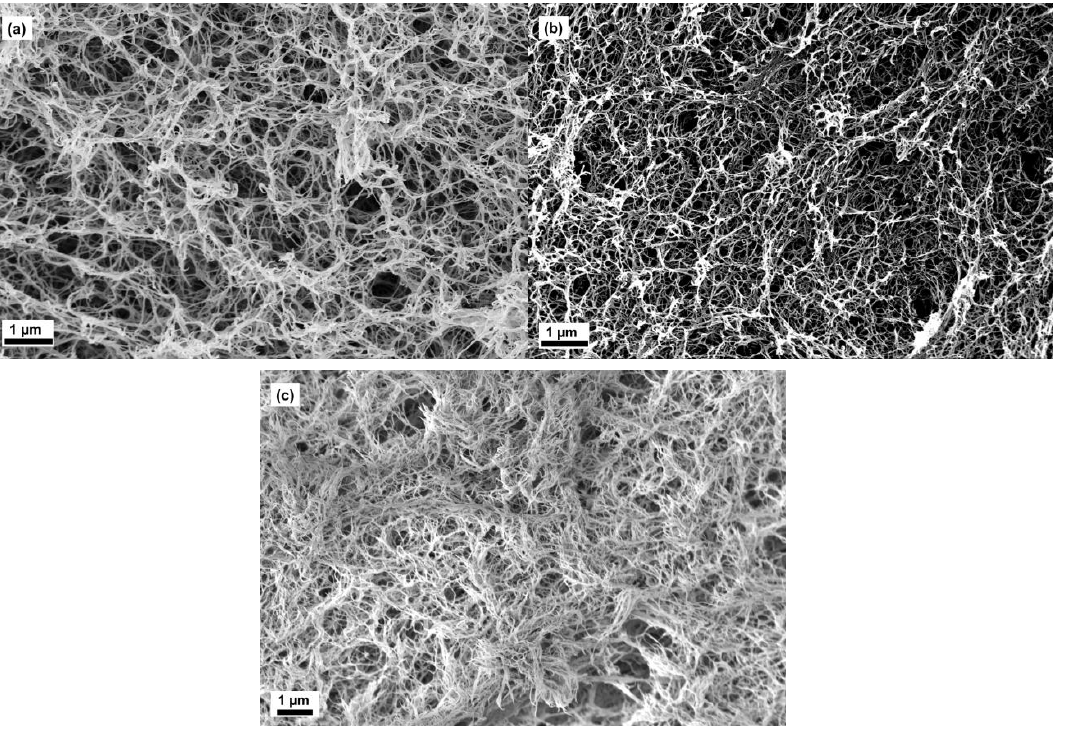
Figure 1. Scanning electron microscopic images of aerogels of cellulose (AC)-2 ( a ), AC-4 ( b ) and AC-6 ( c ). AC-6 ( c